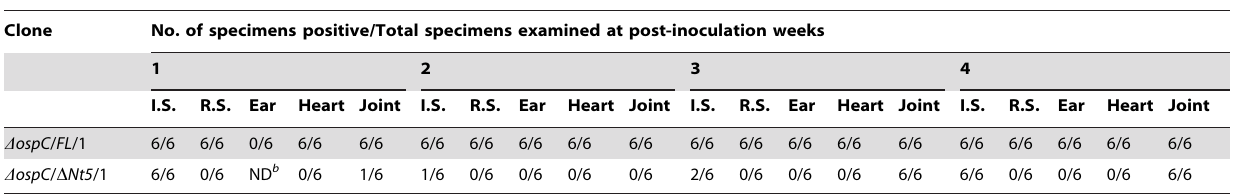
Table 6. The 5-AA deletion severely impairs the ability of B. burgdorferi to disseminate in immunocompetent mice a .